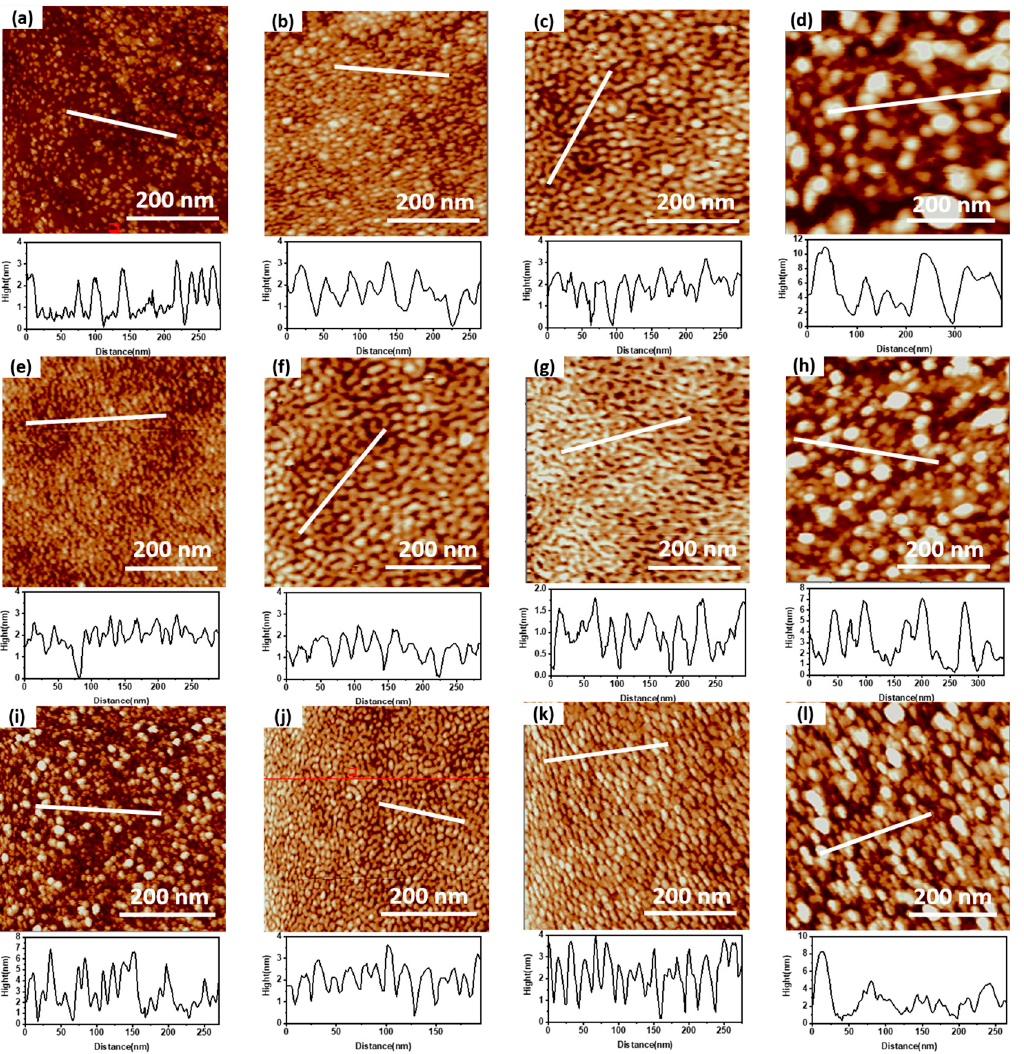
Table 3. Average surface roughness of MoS 2 /C 60 composite film.